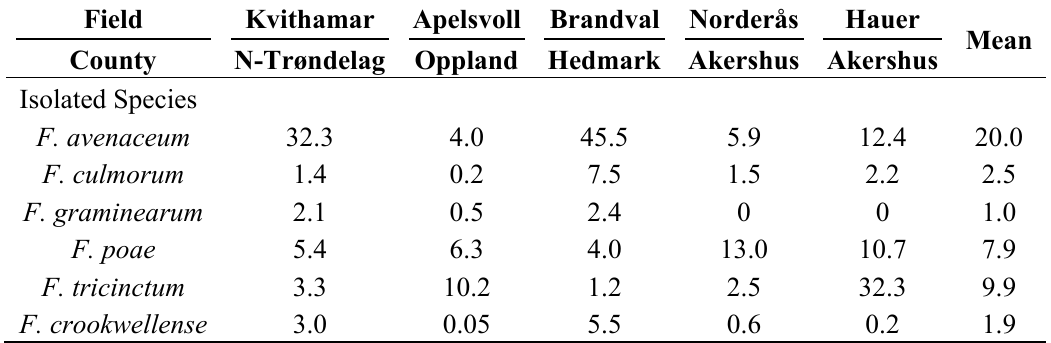
Table 2. Occurrence (%) of Fusarium spp. isolated from seed samples at five experimental fields in Norway from 1994 to 1997, as determined by Henriksen